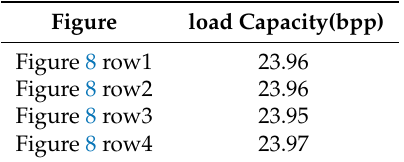
Table 6. Load capacity of randomly selected four sets of